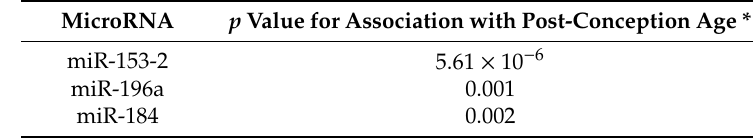
Table 3. Sex-specific di ff erential expression of microRNAs by post-conception age during human lung development.